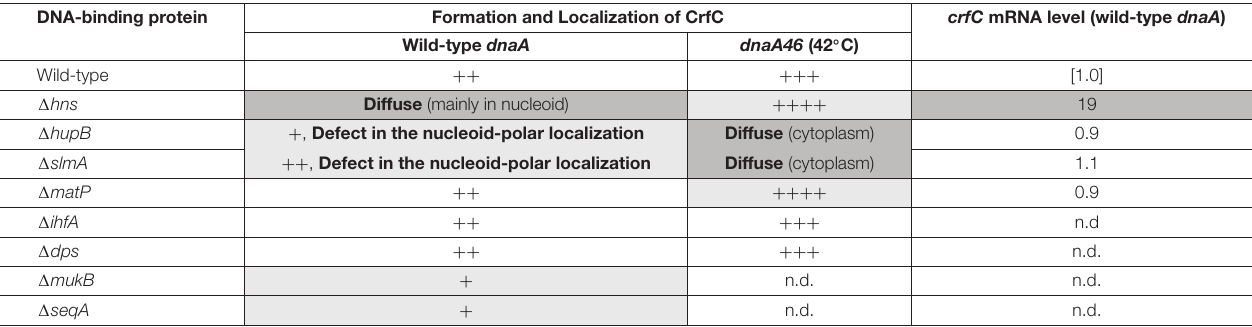
TABLE 1 | Summary of results. DNA-binding